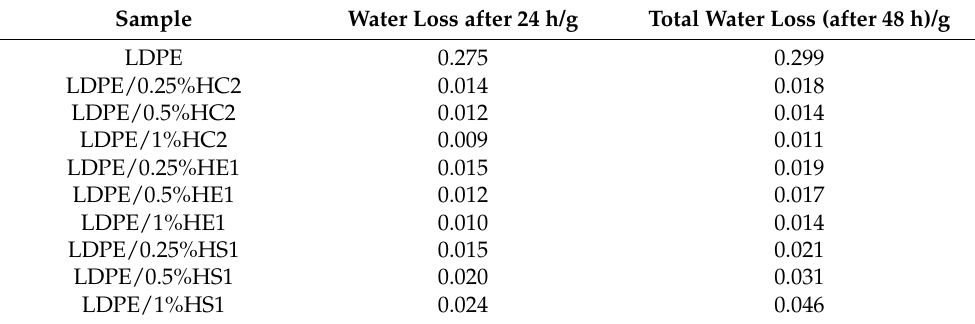
Table 3. Water vapor permeability of LDPE and LDPE/hematite composites.